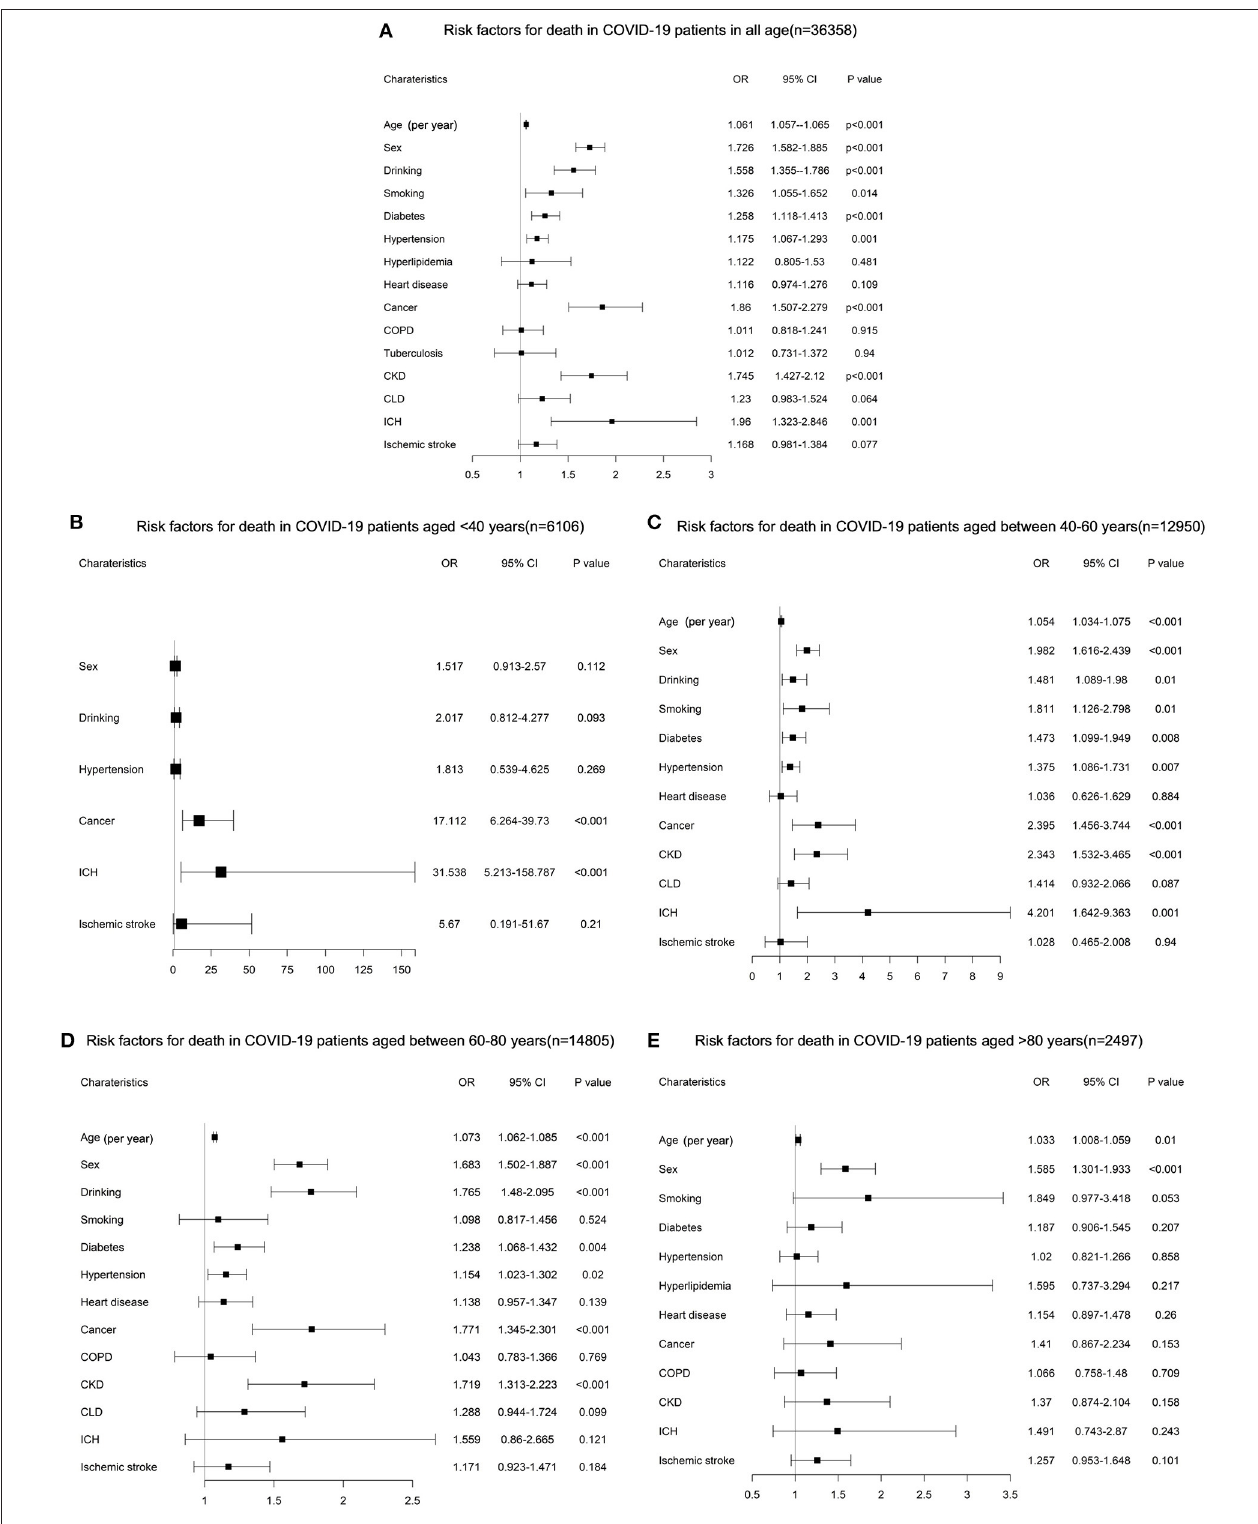
FIGURE 2 | (A) Multivariable logistic regression analysis for risk factors of death in the entire cohort of patients with coronavirus disease 2019 (COVID-19). (B) Multivariable logistic regression analysis for risk factors of death in COVID-19 patients aged < 40 years. (C) Multivariable logistic regression analysis for risk factors of death in COVID-19 patients aged between 40 and 60 years. (D) Multivariable logistic regression analysis for risk factors of death COVID-19 patients aged between 60 and 80 years. (E) Multivariable logistic regression analysis for risk factors of death COVID-19 patients aged > 80 years.